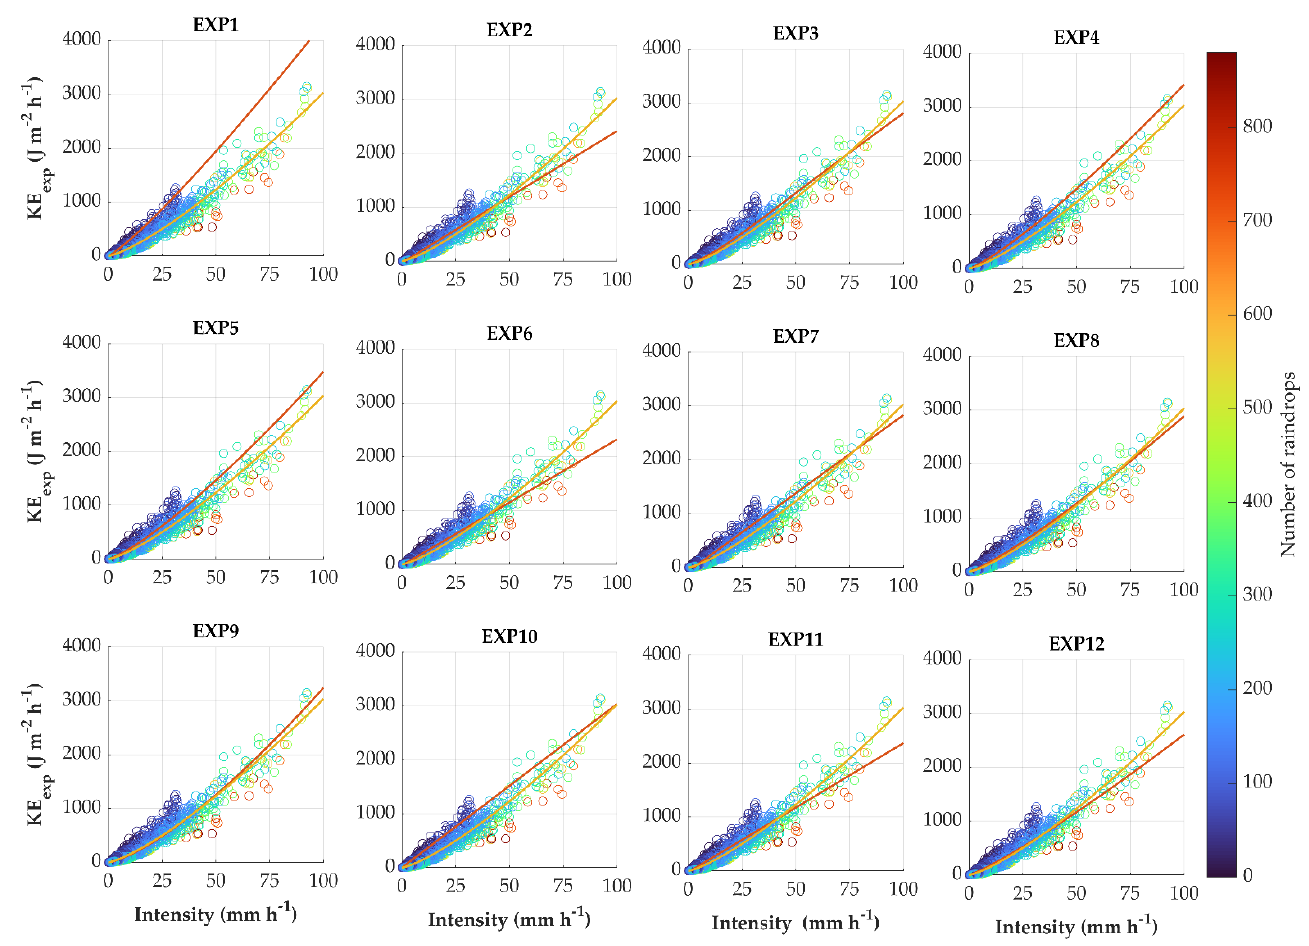
Figure 4. Comparison of 12 KE exp equations (represented by red lines) with measured data. The yellow line represents the fitted line of measured data (EXP13).